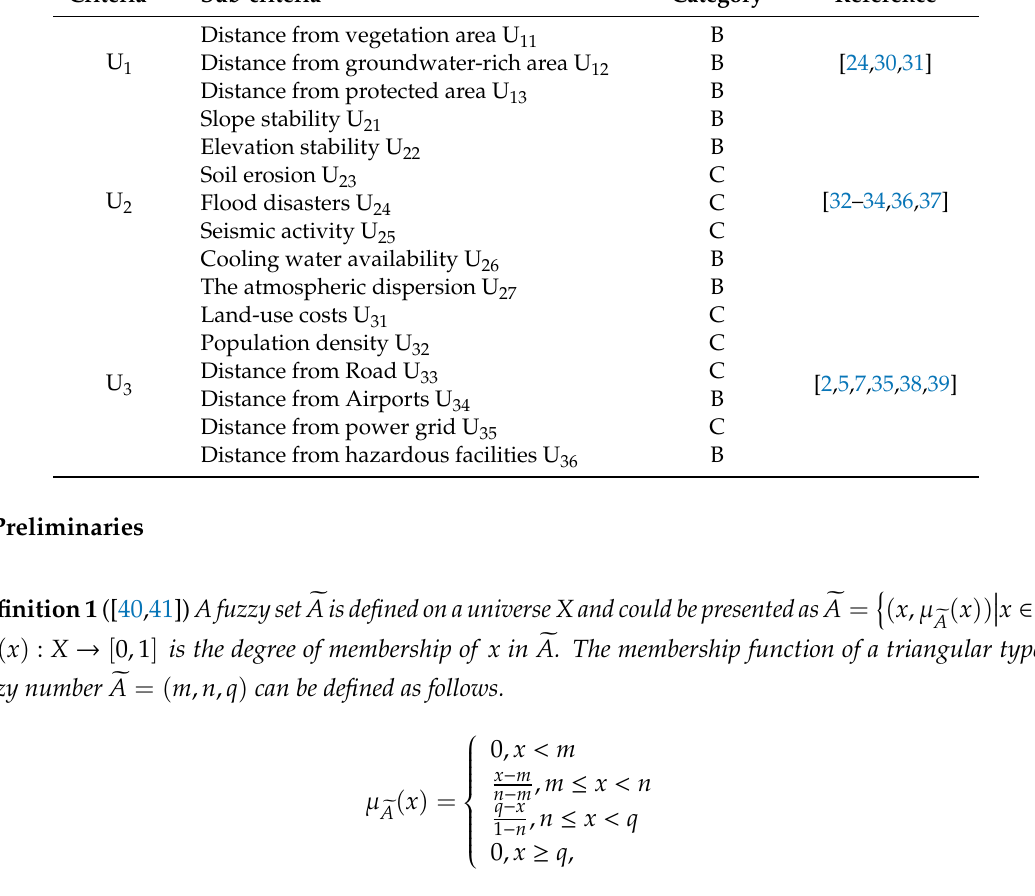
Table 1. The indicator framework for inland nuclear power plant (NPP) site selection.